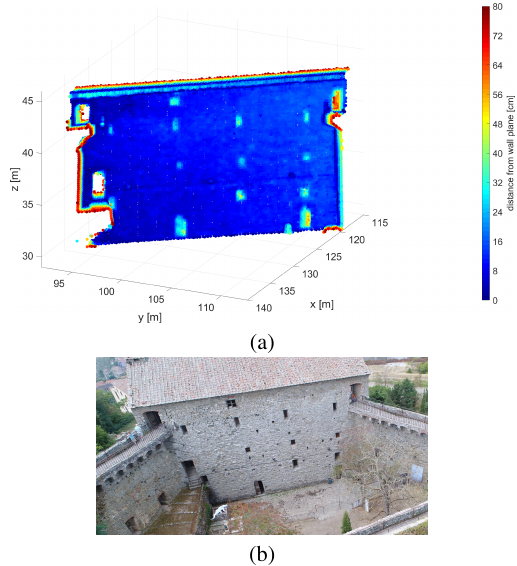
Figure 6. (a) Depth analysis on the wall of the building shown in Fig. 3(a). (b) Area corresponding to (a) shown in a UAV image.